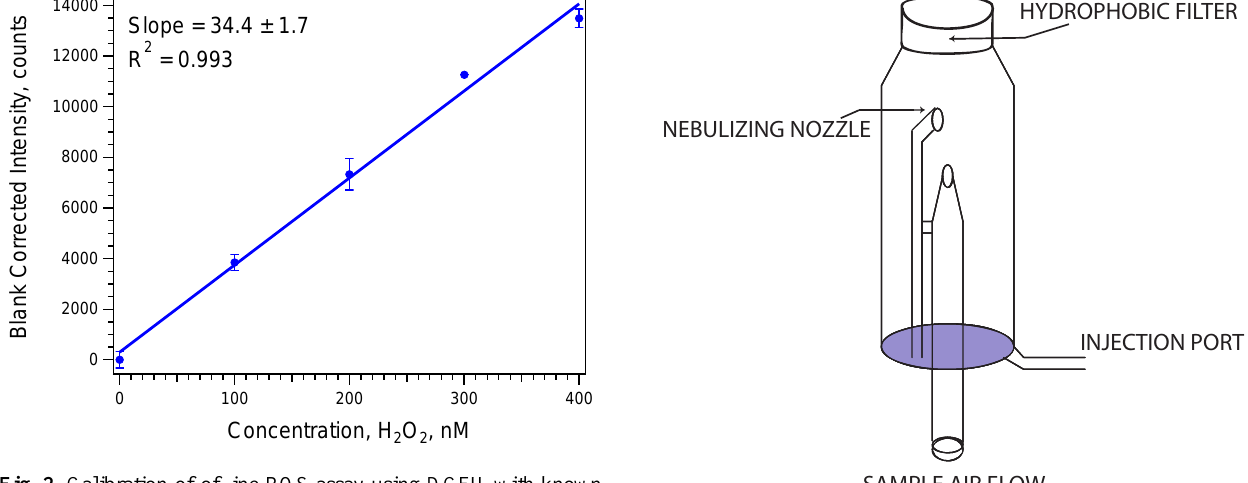
Fig. 2. Calibration of offline ROS assay using DCFH with known concentrations of H 2 O 2 . Error bars represent the standard deviation of multiple measurements ( n = 5). Fig. 3. Schematic of a mist chamber. Liquid is injected and ex-